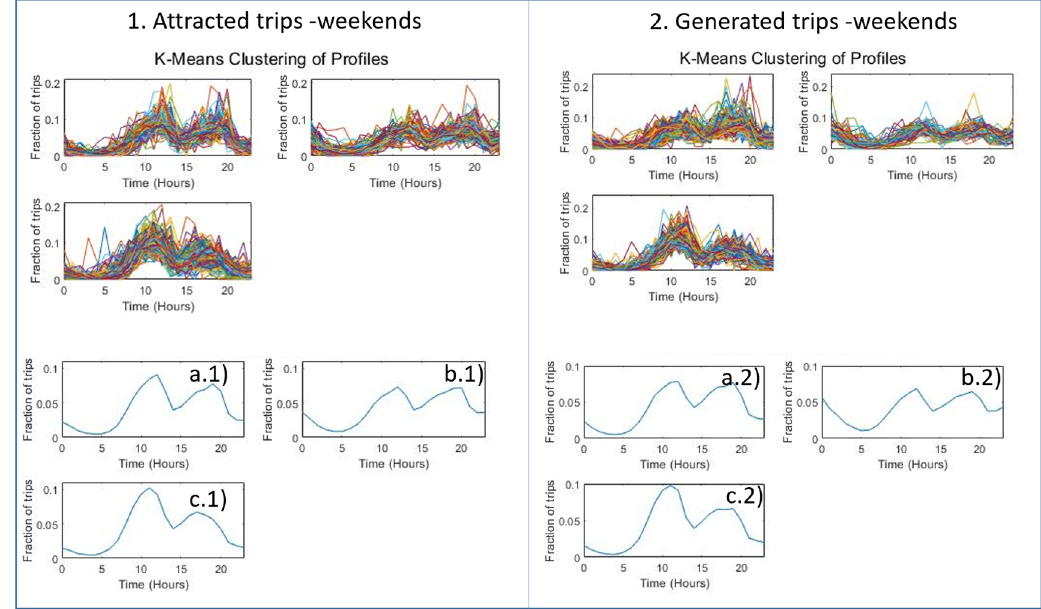
Figure 8. K-means clustering applied to ( 1 ) attracted trips and ( 2 ) generated trips on the weekends. Resulting clusters: residential ( a1 , c2 ), mixed-use ( c1 , a2 ), and nightlife and leisure ( b1 , b2 ).